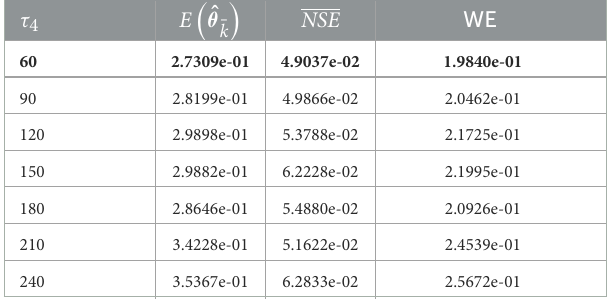
Table 4 Model results for different values of τ 4